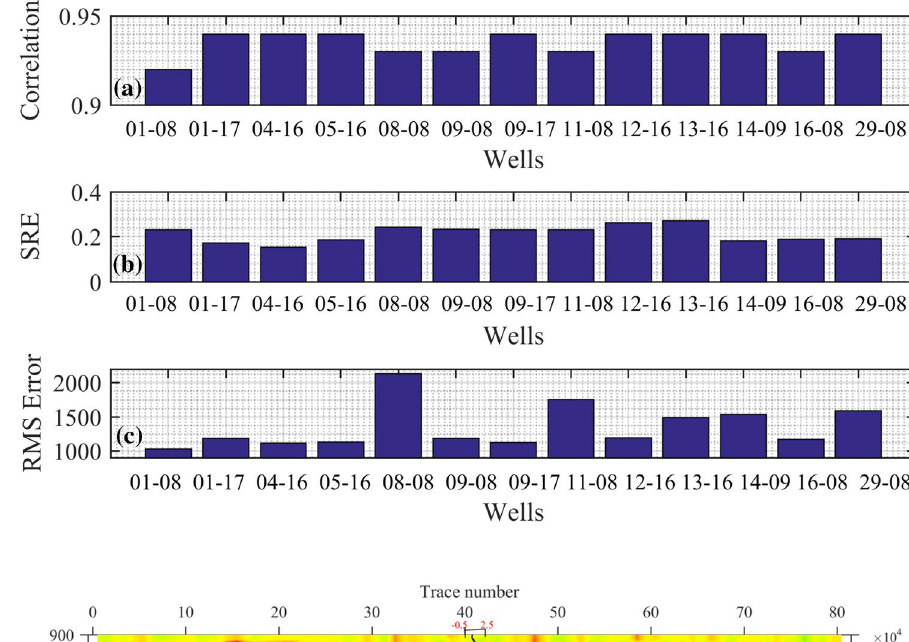
Fig. 7 Cross-section of inverted impedance for inline 118. The special features are highlighted